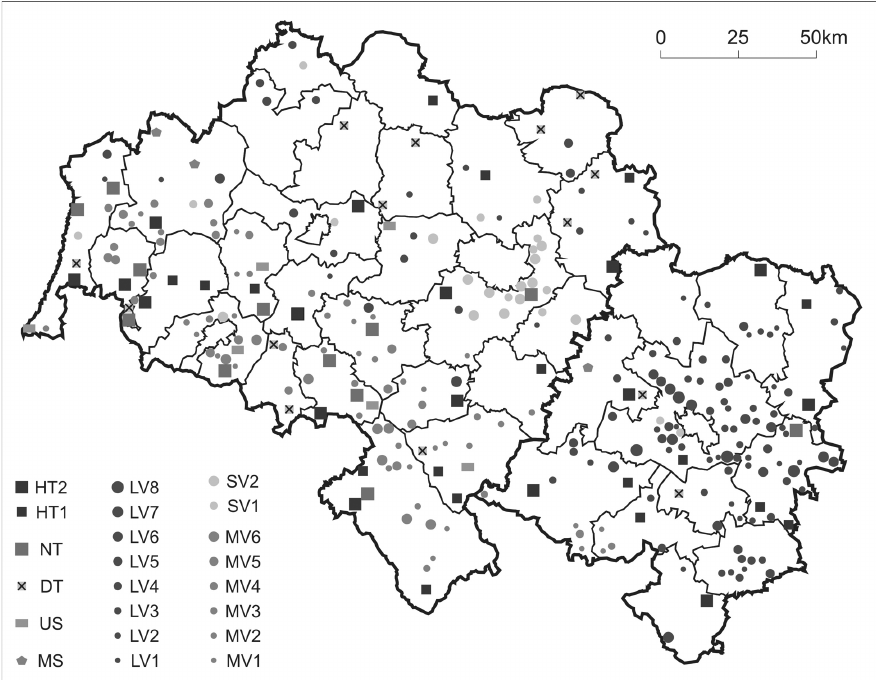
Fig. 6. Types of small towns and big villages in the south-west region of Poland. Source: own work. Explanations of types in Table